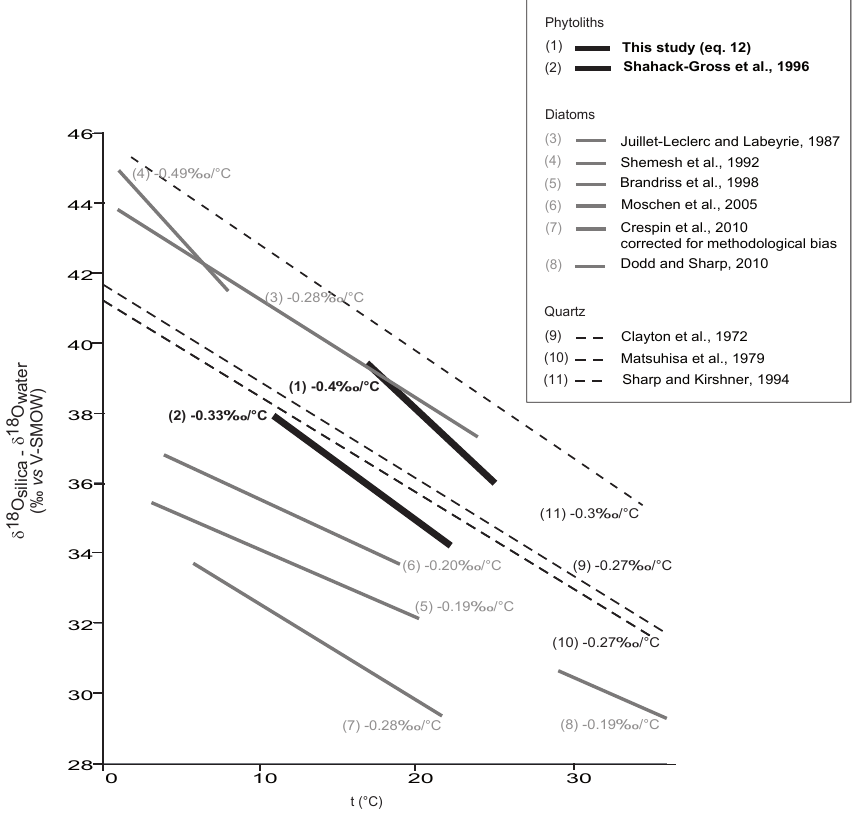
Fig. 7. Comparison of the thermo-dependant relationships expressed as 1000ln α ∼ [ δ 18 O silica − δ 18 O water ] (‰ vs. VSMOW)=at( ◦ C)+ b obtained for phytolith-water, diatom-water and quartz-water